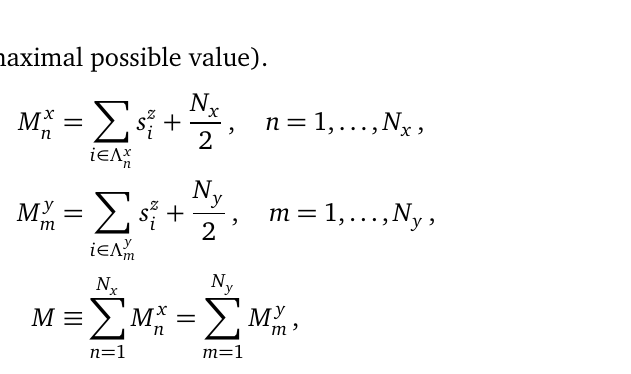
Figure 2: (Left) The ring exchange term acts on elementary plaquettes ( i jkl ) . Sub- system symmetry operators ˆ U x respectively. (Right) The number of non-empty symmetry sectors for systems of size N × N , for N =